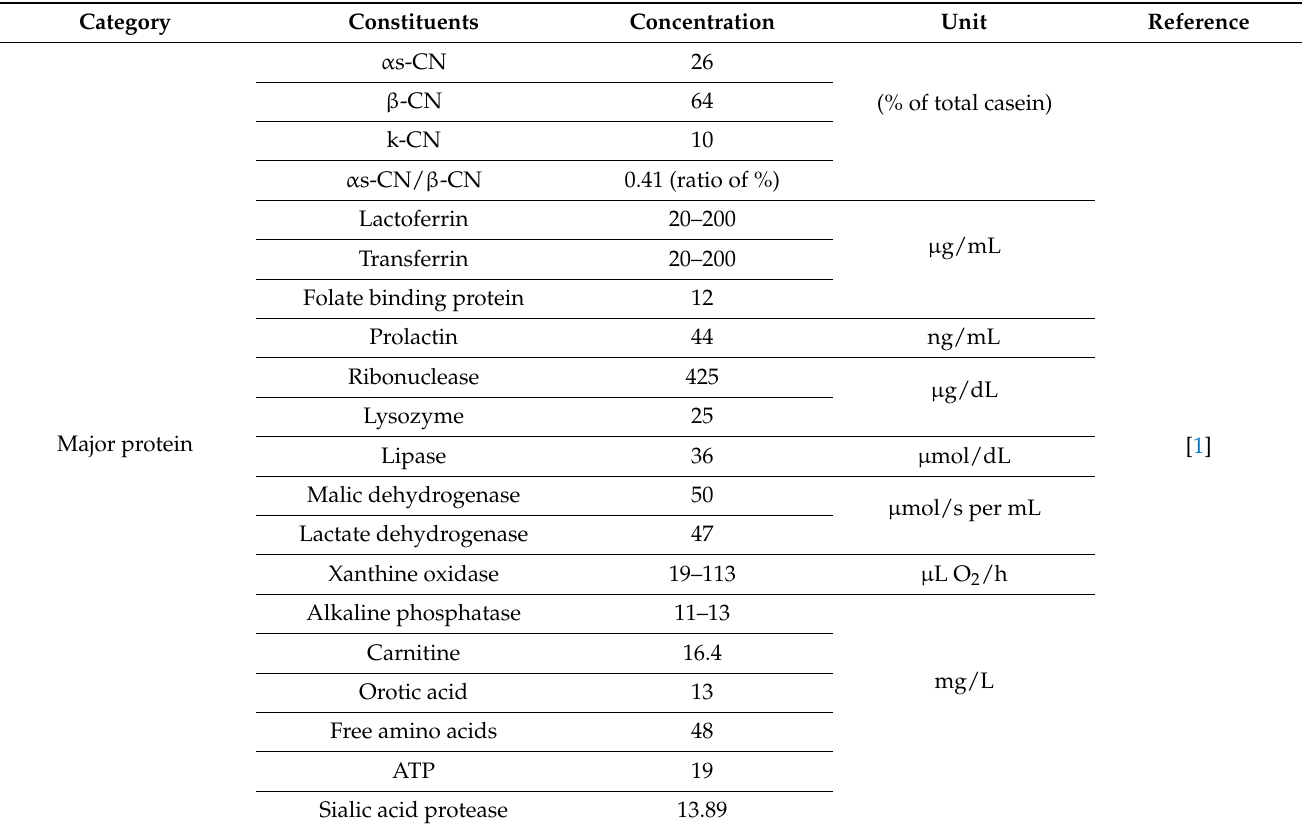
Table 2. The different components of proteins and their compositions found in goat